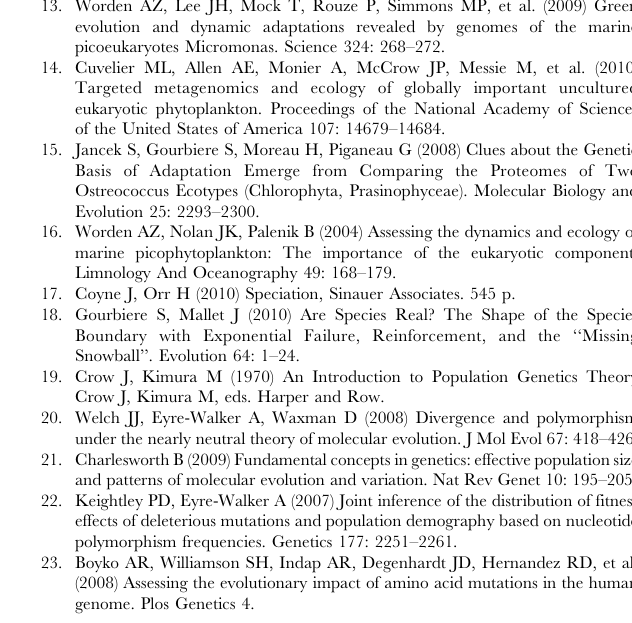
Figure S1 Phylogenetic relationships and number of genes used for independent